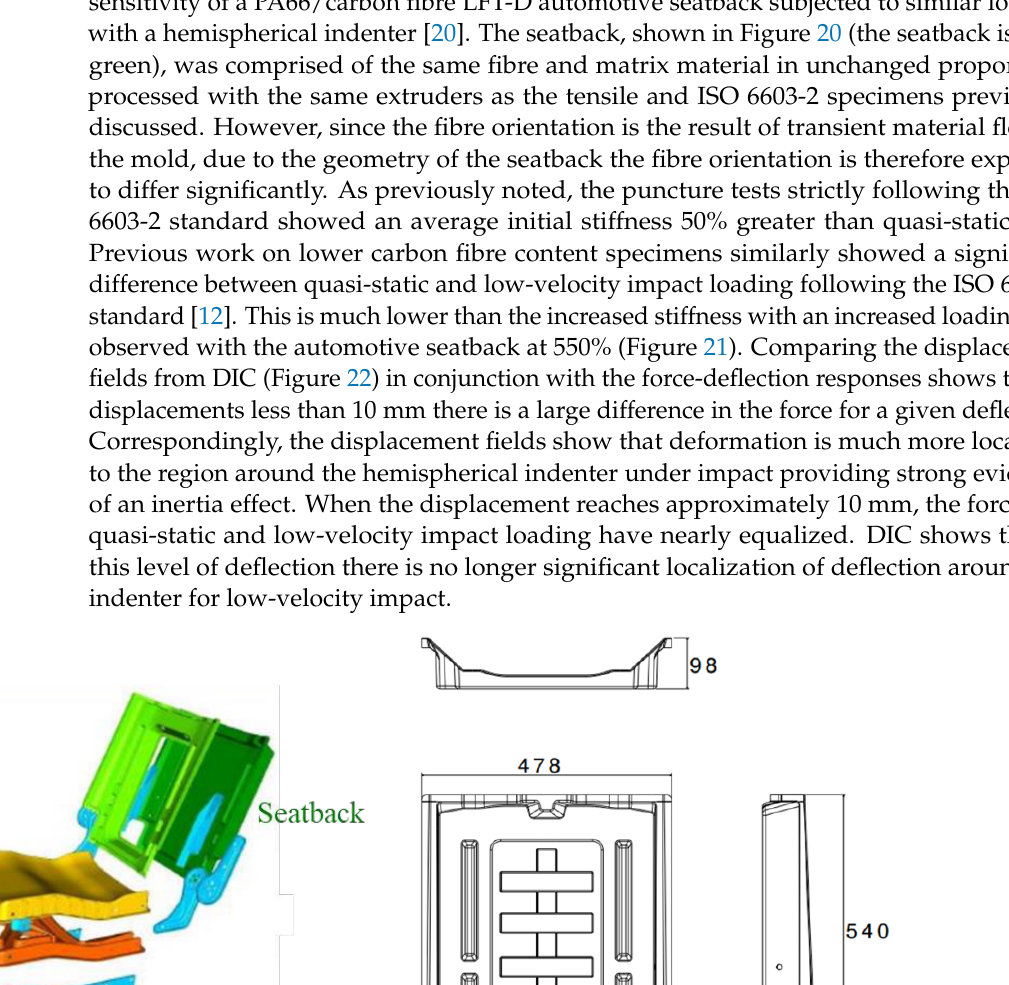
Figure 21. Comparison of quasi-static and low-velocity impact test force-deflection responses of car- bon fibre LFT seatback components.